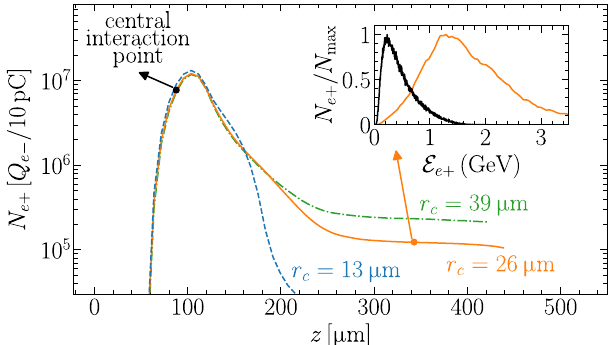
FIG. 4. The number of injected positrons as a function of the laser propagation distance for different channel sizes. The black circle marks the central interaction point of the laser pulse with the photon beam. Inset: Positron energy spectrum for r c ¼ 26 μ m at creation time (black). The total charge is 1.3 pC and N ¼ 6 pC = GeV. Positron spectrum at z ¼ 340 μ m. The total max ¼ 12 fC = GeV. The normalization charge is 17 fC and N max facilitates the scaling of the result to a higher electron beam